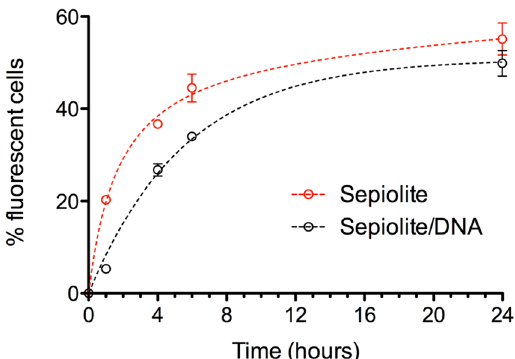
Figure 5. Time kinetics for sepiolite versus Sep/DNA interaction with V79 cells. 100 μ L of sepiolite